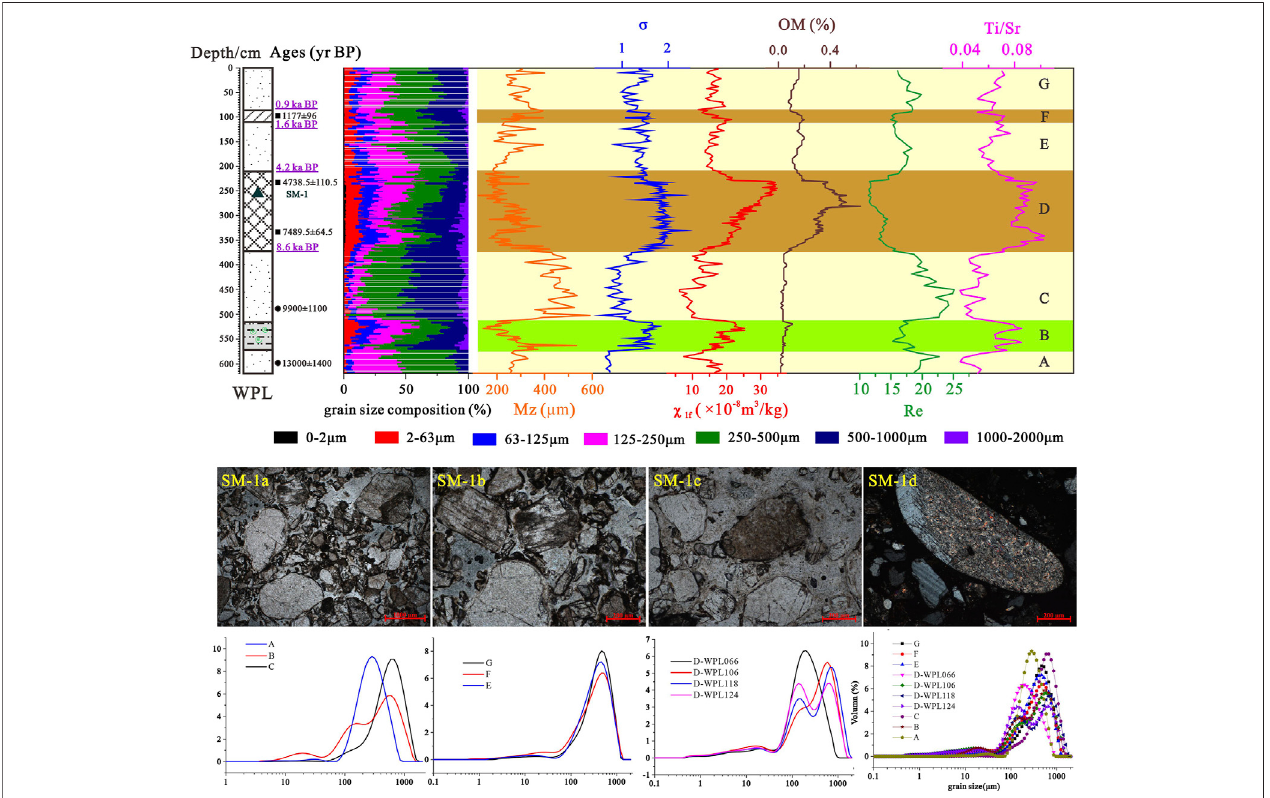
FIGURE 3 | Upper panels: the environmental proxies ’ variation over the WPL pro fi le. The legend of the pro fi le is same as Figure 2 . Middle panels: the characteristics of the soil micromorphology of sample SM-1. SM-1a, SM-1b, SM-1c were identi fi ed under plane-polarized light and SM-1d was identi fi ed under cross- polarized light. The scales are 200 μ m. Lower panels: representative grain size frequency distribution curves for the WPL section.